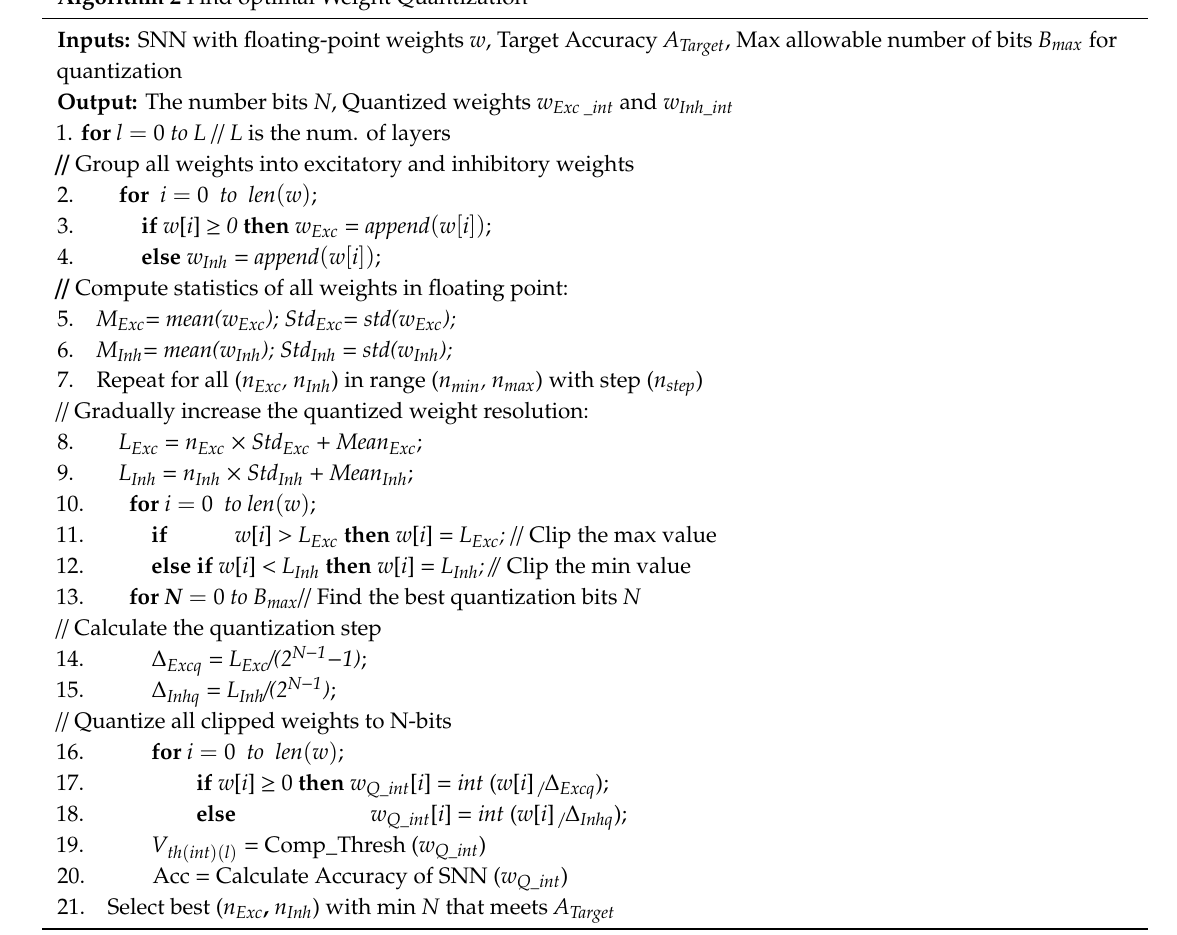
Algorithm 2 Find optimal Weight